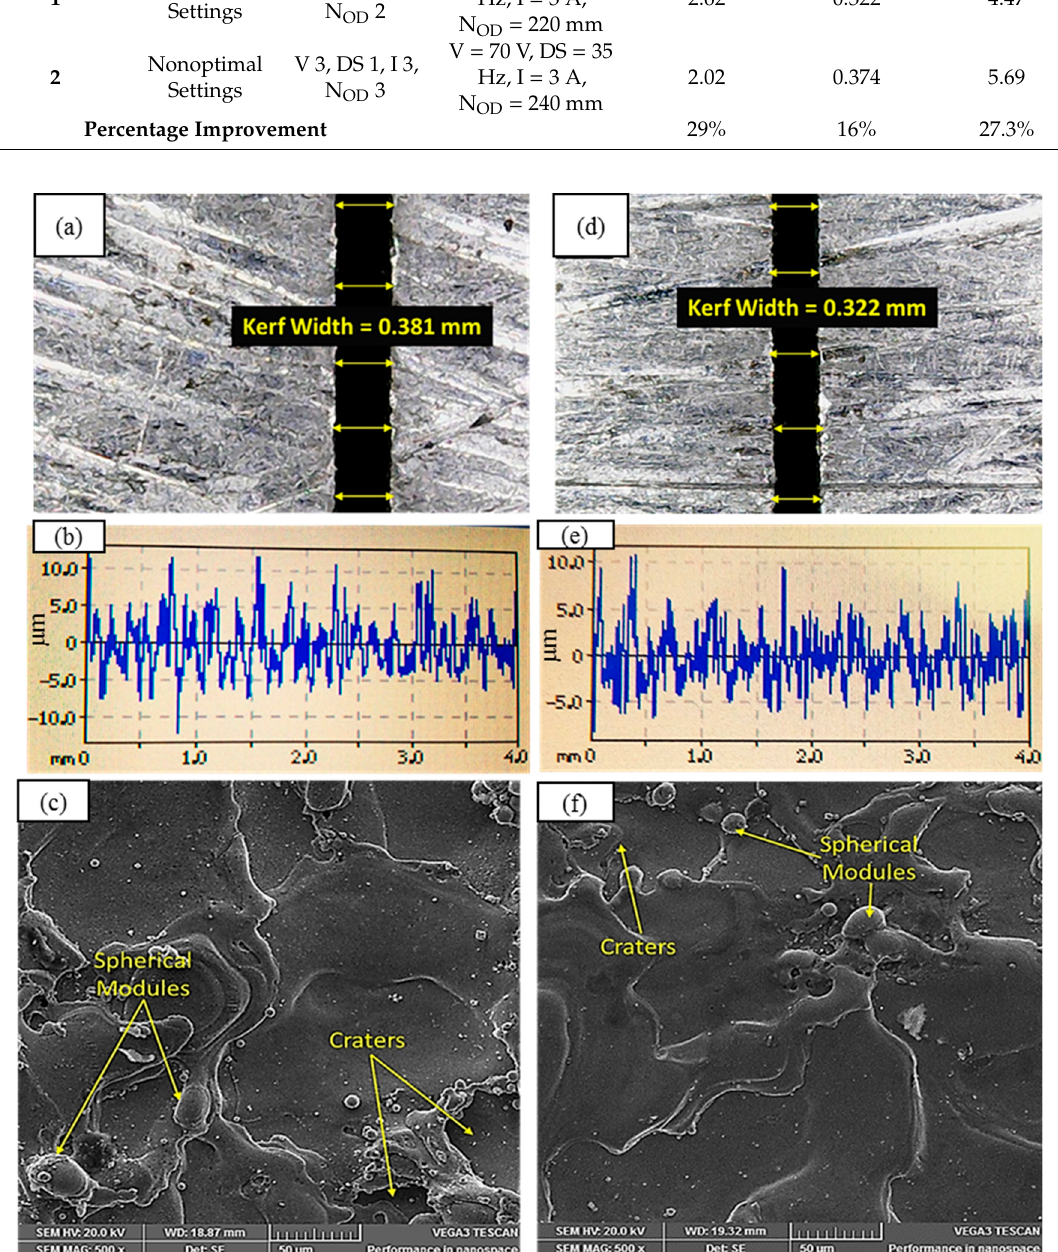
Figure 11. Kerf width, surface roughness, and SEM micrographs of machined surface under: ( a – c ) nonoptimal settings—V = 70 V, DS = 35 Hz, I = 3 A, and N OD = 240 mm; and ( d – f ) optimal setting—V = 50 V, DS = 35 Hz, I = 3 A, and N OD = 220 mm. Table 5. Results of confirmatory test.